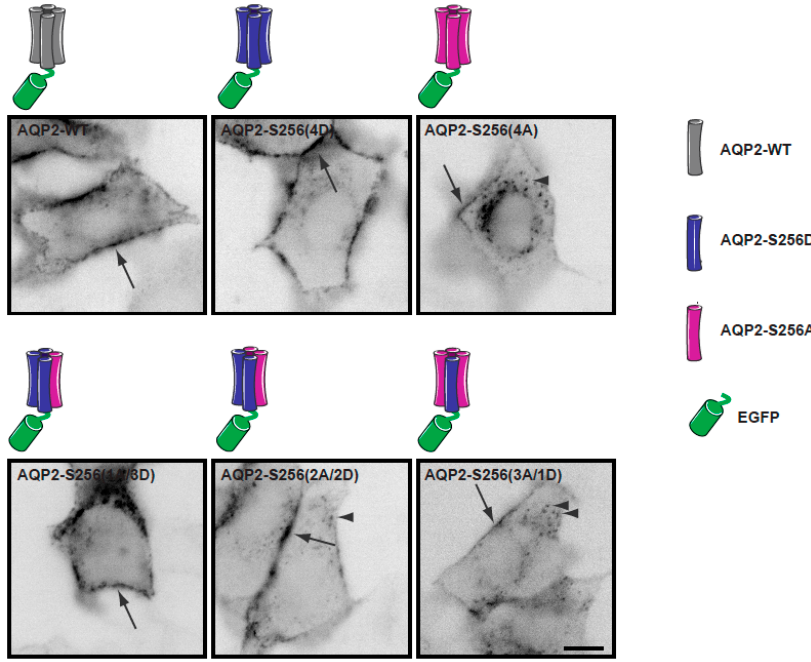
Figure 3. Subcellular localization of the different homo- and heterotetramers mimicking different degrees of Aquaporin-2-S256 (AQP2-S256) phosphorylation. Representative fluorescence images